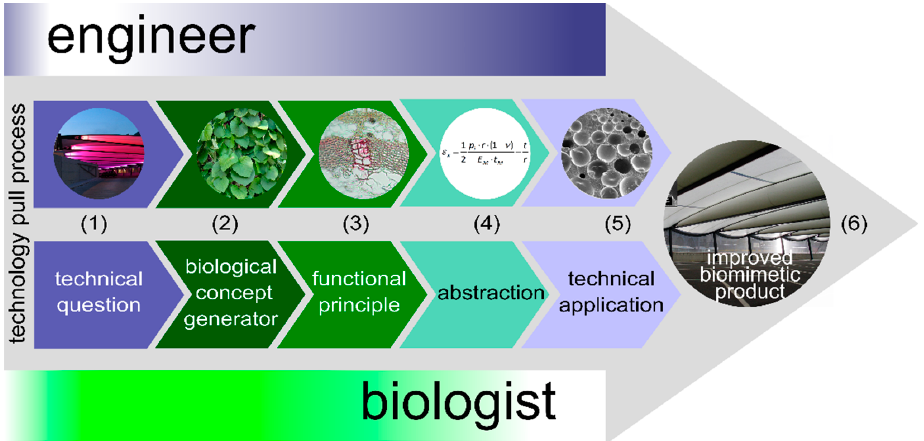
Figure 6. The top-down approach (technology pull process) of a self-sealing foam membrane coating for pneumatic structures. (1) How can fissures in the membranes of pneumatic systems such as the Tensairity ® technology (Airlight Ltd., Biasca, Switzerland) technology be rapidly closed? (2) The Dutchmen’s Pipe ( Aristolochia macrophylla ) has proved to be a suitable role model. (3) Growth-related (micro)fissures in the peripheral strengthening tissue of the stems are rapidly closed by sealing cells. The underlying functional principle is based on turgescent (under internal overpressure) nonlignified parenchyma cells that swell into the fissures. (4) Inspired by these turgescent sealing cells, a polyurethane foam coating was applied to the membrane on the inside of the pneumatic structure. The self-sealing foam consists of closed-cells and is polymerized under an overpressure of 1–2 bar. The interaction of the material properties and geometric parameters of the coated membrane can be described by a mathematical equation. (5) The self-sealing foam was tested and further developed in cooperation with an industrial partner on a pilot plant scale. (6) Membranes equipped with the commercially available foam can be incorporated into a multitude of pneumatic systems. Slightly modified and reproduced with permission from [4] Copyright ©